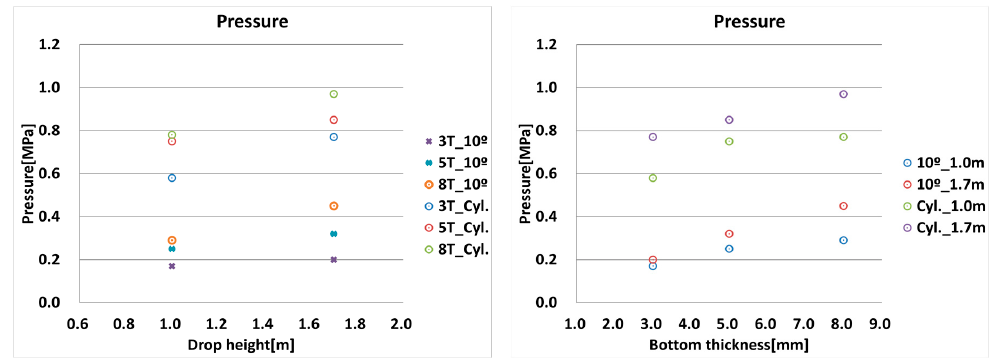
Figure 22. Comparison of peak pressures.